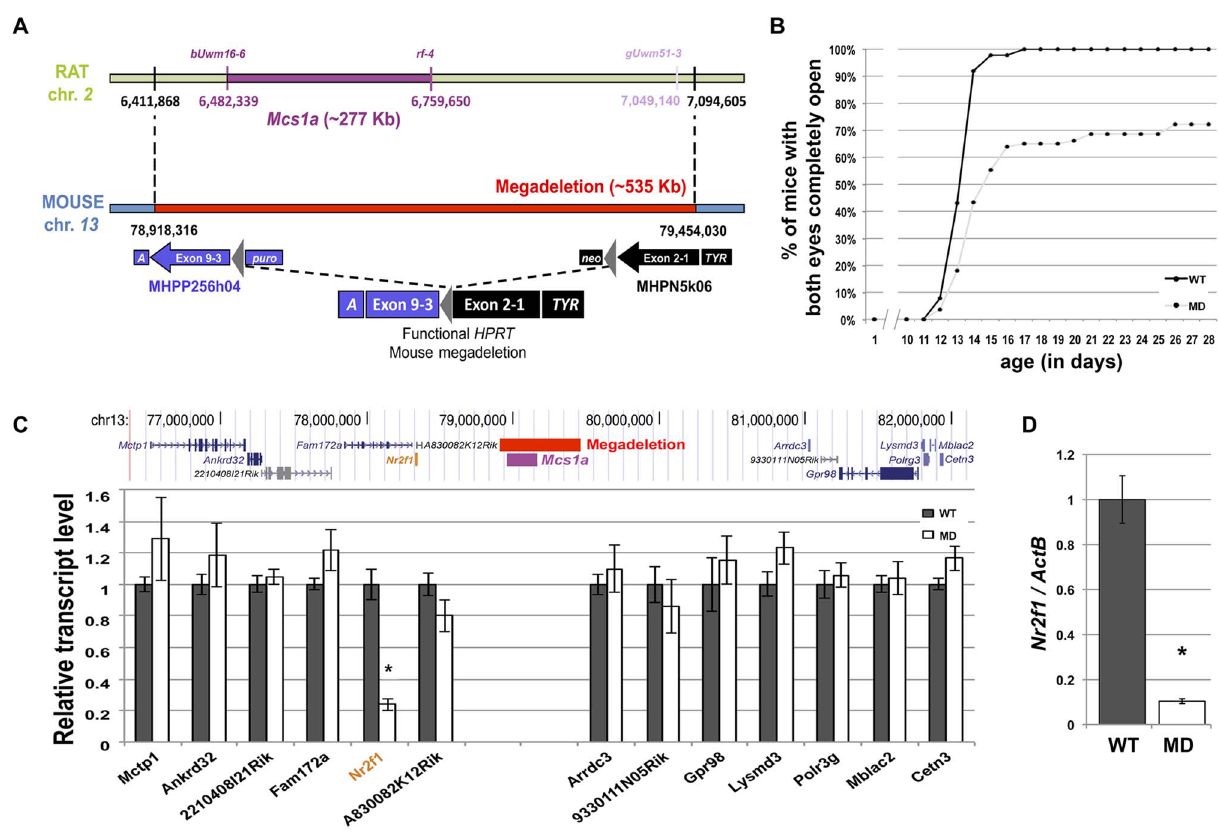
Figure 2. A megadeletion (MD) mouse model for the rat Mcs1a locus reveals Nr2f1 as the Mcs1a target gene. A) Schematic representation of the rat Mcs1a locus and mouse orthologous locus that was deleted using mutagenic insertion and chromosome engineering resource (MICER) vector-assisted targeting. The horizontal bar, genetic markers and chromosomal base pair positions in purple represent the location of the Mcs1a critical interval on rat chromosome 2 (UCSC Genome Browser, rn4). The marker and base pair position in light purple delineate the location of the distal end of the Mcs1a critical interval at the time of design of the MICER project. The MD on mouse chromosome 13 is depicted as a red horizontal bar. The coordinates (in bp) are from the 2007 version of the mouse genome (UCSC Genome Browser, mm9). At the indicated base pair positions, a compatible pair of MICER vectors was placed, such that upon Cre-recombinase-driven excision in the embryonic stem-cell stage, a functional Hypoxanthine-guanine phosphoribosyltransferase ( HPRT ) gene was formed, which allowed for selection of a correctly targeted ES cell clone. Construct MHPP256h04 contained Agouti ( A ), HPRT exons 3–9, loxP (grey triangle) and a Puromycin resistance gene ( puro ); Construct MHPN5k06 contained a Neomycin resistance gene ( neo ), loxP (grey triangle), HPRT exons 1 and 2, and Tyrosinase ( TYR ). B) Graph showing the delayed eye- opening phenotype in MD mice (n=83; FVB) as compared with WT littermates (n=88; FVB). Plotted are on the vertical axis the percentage of mice in each genotype group with both eyes completely open and on the horizontal axis age in days. C) RNA-seq analysis of mammary gland gene expression from MD and WT control mice (n=4 each; FVB). The transcript levels are shown as the average ( + / 2 sem) counts from the RSEM algorithm output (used to estimate transcript levels [37]), normalized to the average of the WT group. Shown are transcripts within 2.5 Mb surrounding the gene desert. Only the transcript level of the orphan nuclear receptor gene Nr2f1 was significantly different between MD and WT mice (P , 0.05, indicated by an asterisk). D) Quantitative real-time PCR (Q-PCR) analysis verifying the differential transcript level of Nr2f1 in mammary gland from MD and WT control mice (n=12 each; FVB). The Nr2f1 transcript level is shown relative to the transcript level of the ActB endogenous control gene. genetic backgrounds (Figure 2B, shown for FVB). While all WT animals had both eyelids completely open by 17 days of age, this was observed for only 65% of homozygous MD mice. For some animals, the closed eyelid phenotype persisted for months (unpublished data).